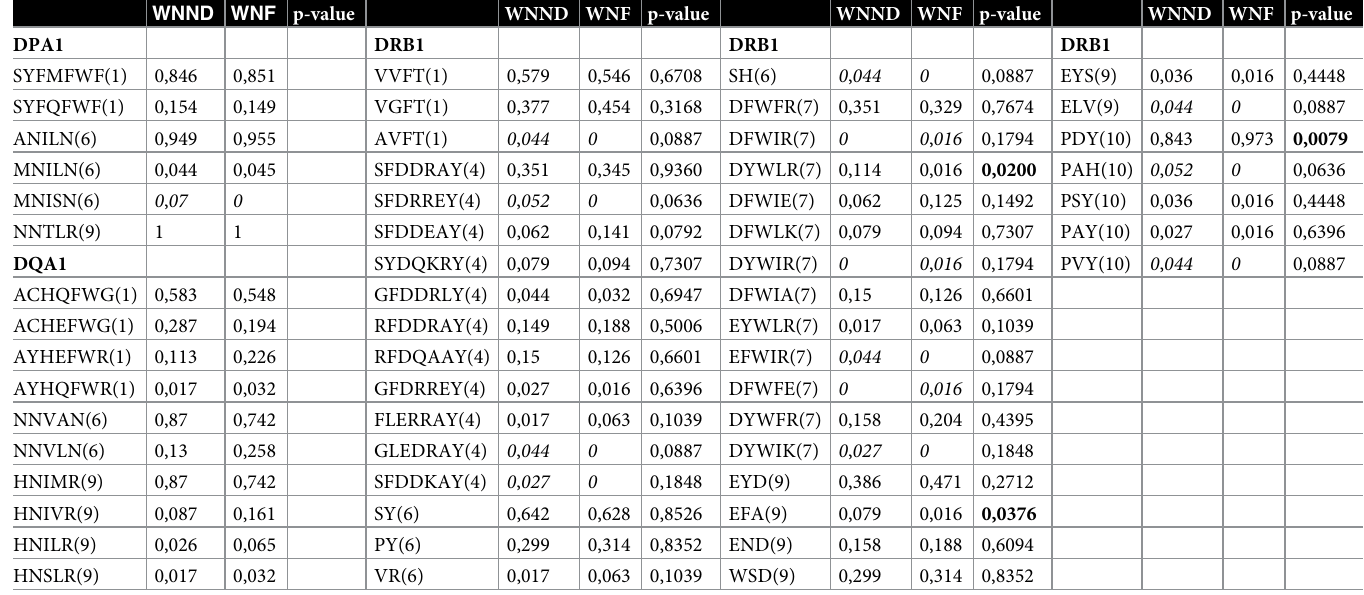
Table 1. The pocket variants and their frequency found in HLA-DPA1, -DQA1 and -DRB1 in both WNND and WNF case groups. The pocket in which each variant belongs is shown on the left of the variant. The variants found exclusively in one of the groups are shown in italics (in the WNND/WNF columns).